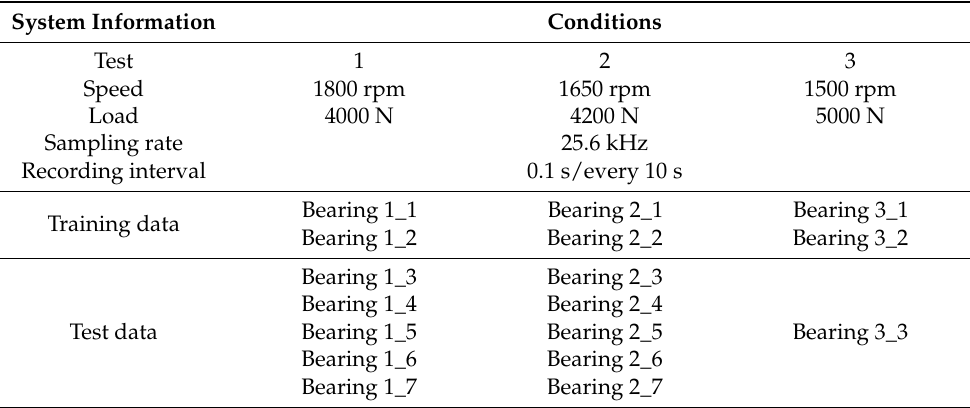
Table 2. Three test conditions for the FEMTO-ST